Question: In one sentence, what is this figure communicating?
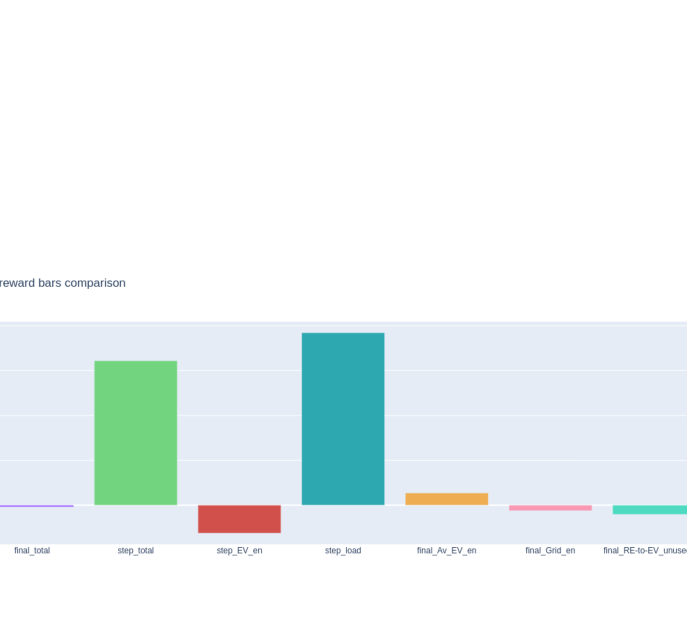
Answer: 3: Final reward functions implemented in the VPP environment.